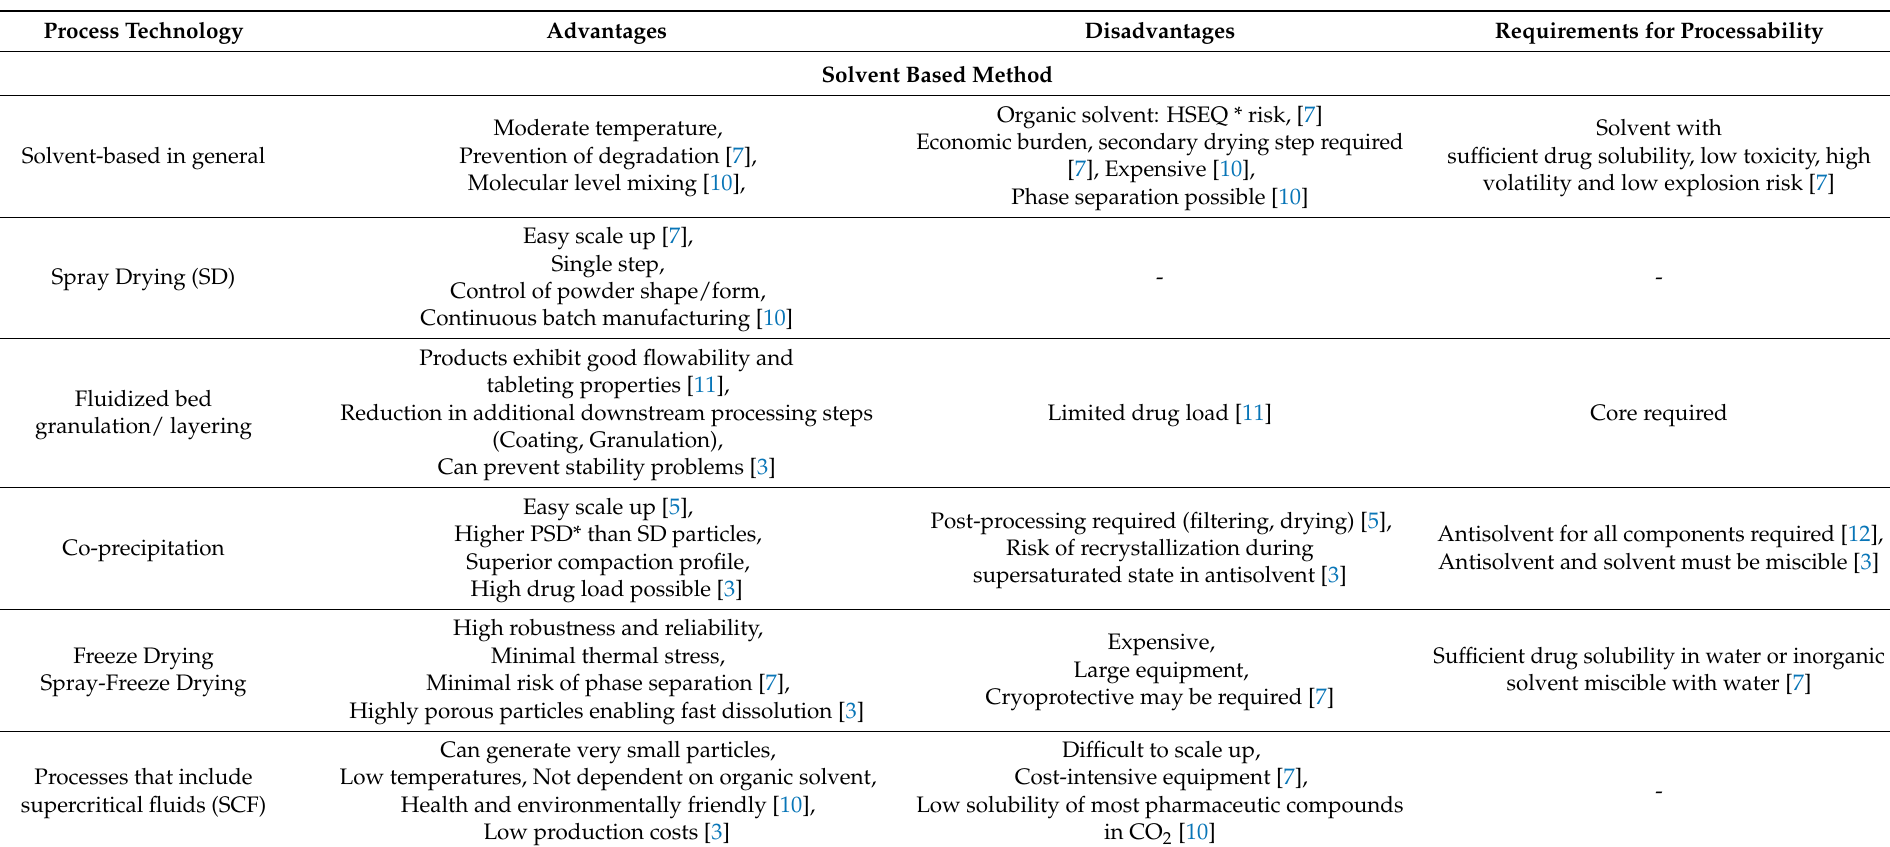
Table 1. Process technologies for solvent- and fusion-based ASD manufacturing methods: advantages and